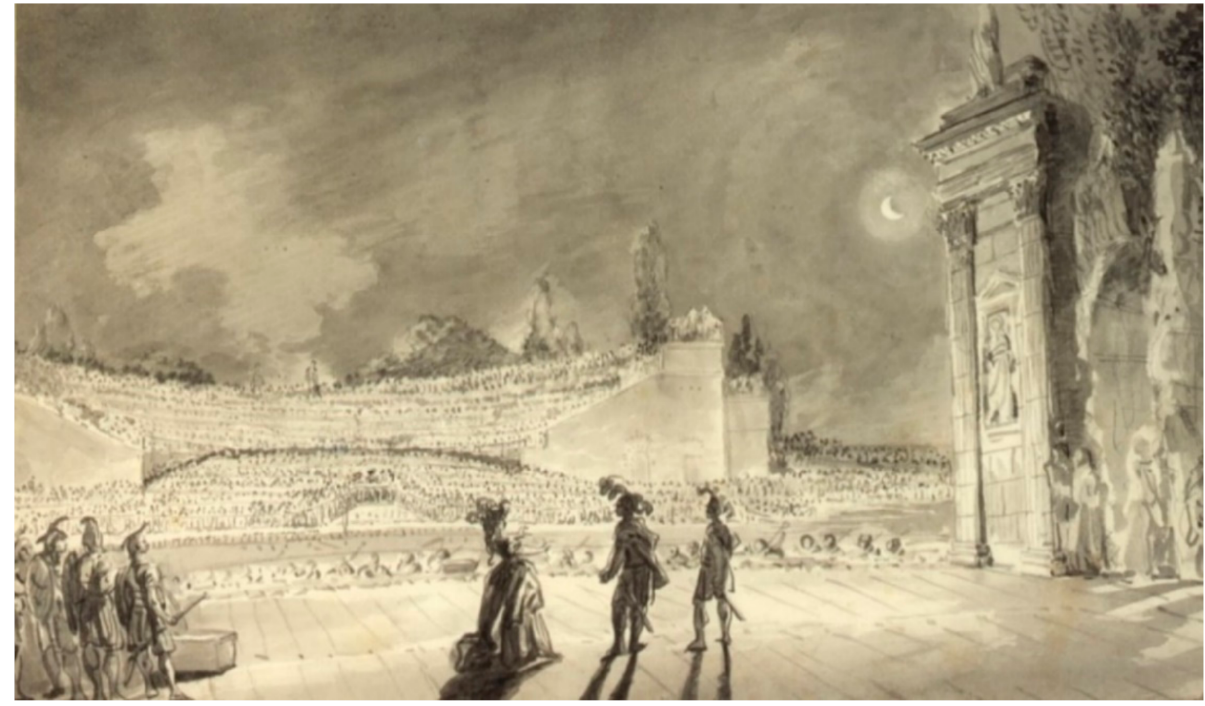
Figure 3. The author’s graphics—the electoral field with a temporary building for senators called “The Shed”, based on the painting The electoral field of 1764 Author Jean-Pierre Norblin de La Gourdaine. Adapted from ref. [12]. Adapted from ref.